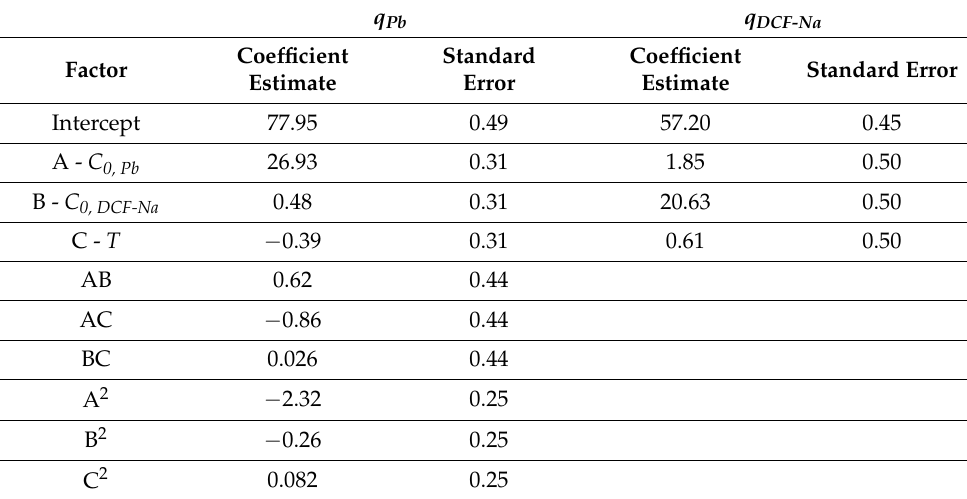
Table 7. Factor coefficients of the models generated by CCD.